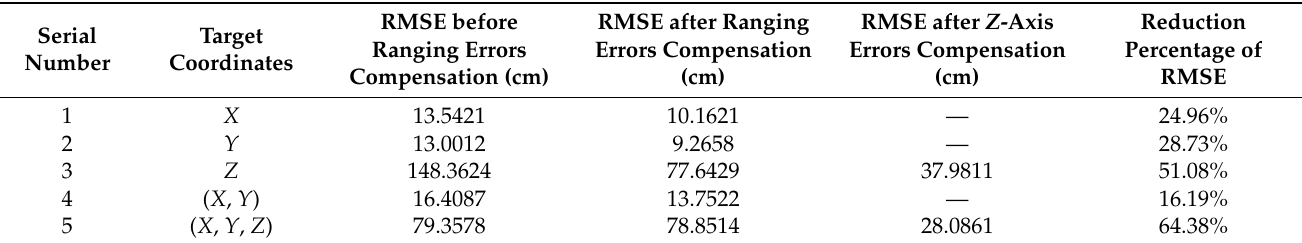
Figure 14. The comparison of Z -axis test set errors compensation with signal interference. Table 5. RMSE before and after errors compensation with signal interference.